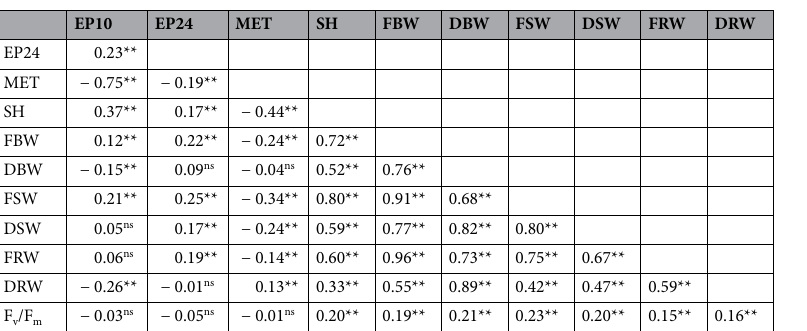
Relationship between investigated parameters. Statistical evaluation results (R and P values) of the linear relationships between investigated parameters are presented in Table 8. There were significantly important ( P < 0.01) positive correlations between parameters of shoot height, fresh biomass weight, dry biomass weight, fresh shoot weight, dry shoot weight, fresh root weight and dry root weight, although, most of the R values seems to be low which indicates a non-linear correlation. Mean emergence time has a negative correlation with all other investigated parameters except dry biomass weight and F v /F m ratio (not significant), and dry root weight (a positive correlation). The substantial positive linear correlation was obtained between fresh biomass weight versus fresh root weight (96%) and fresh shoot weight (91%); dry biomass weight versus dry root weight (89%) and dry shoot weight (82%); shoot height versus fresh shoot weight (80%) and fresh shoot weight versus dry shoot weight (80%). The prominent negative relationship was observed between emergence percentage at 10